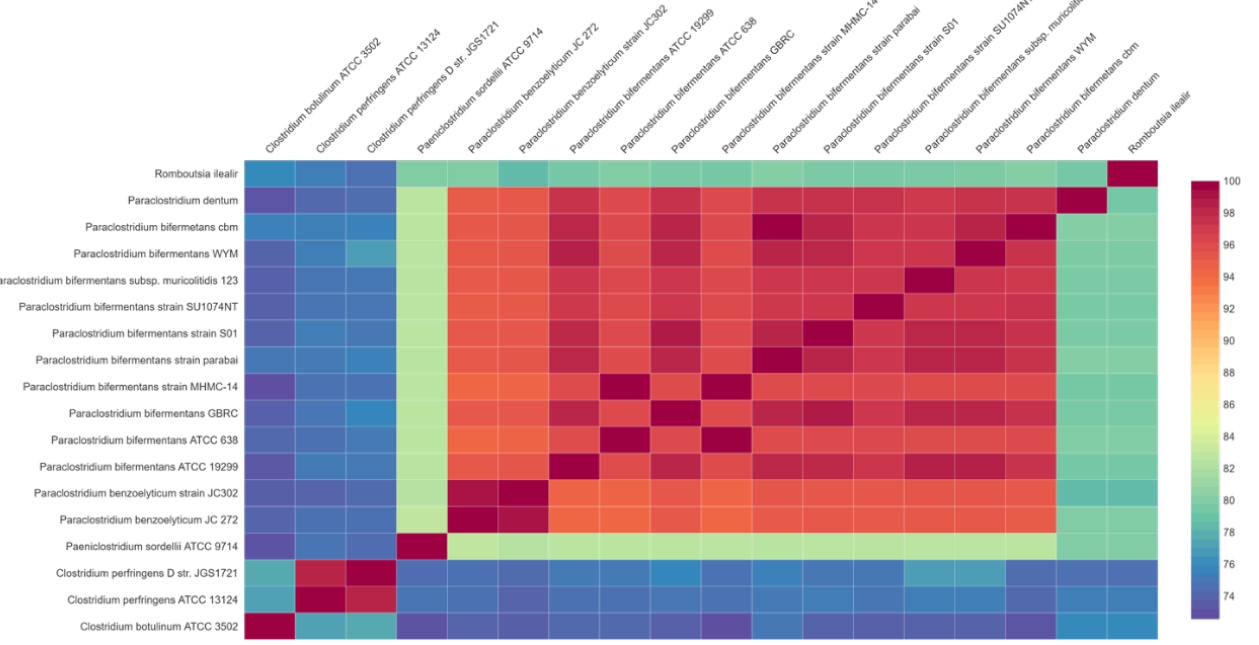
Figure 2. Relationship of P. bifermentans GBRC among other 17 closely related organisms. The aver- age nucleotide identity (ANI) matrix was generated using ANI calculator and the enveomics collec- tion toolbox genome was used for distance matrix calculation.